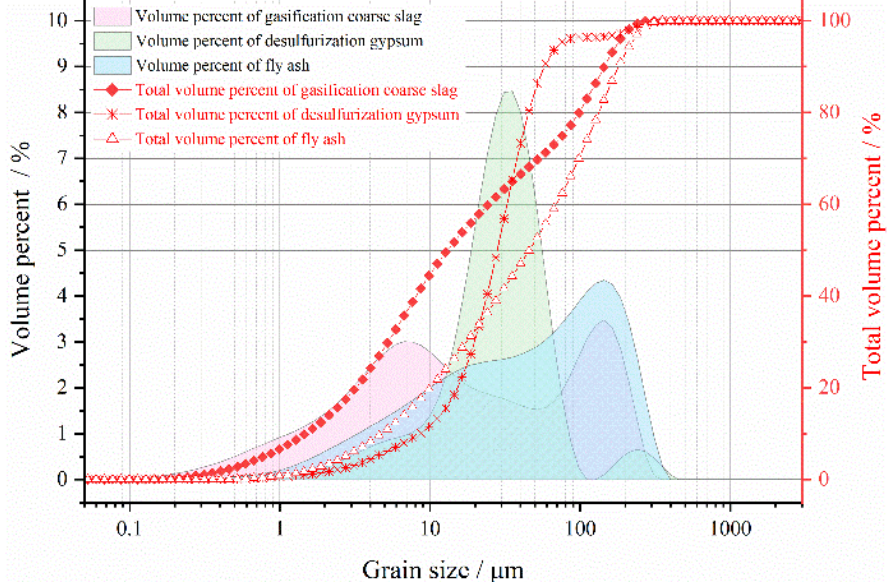
Figure 4. Particle-size distribution of FA, GCS, and FGD gypsum.